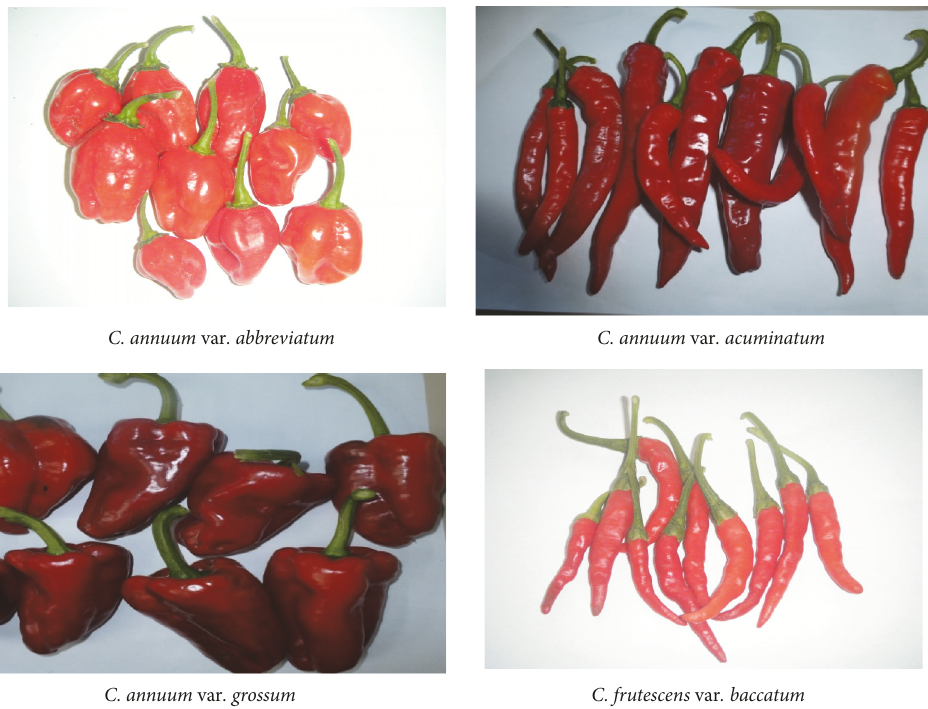
Figure 1: Images showing the typical shapes and sizes of the four varieties of the cultivated Capsicum species in West Africa assessed for their phytochemical content and antioxidant